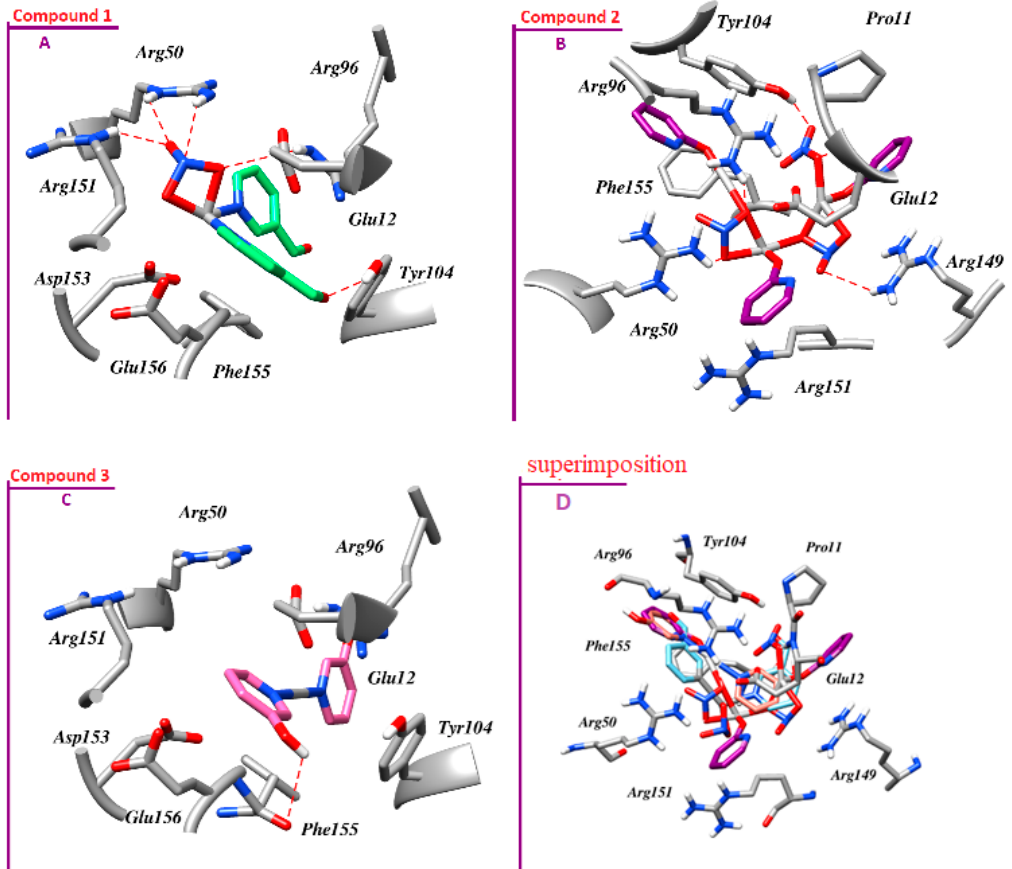
Figure 12. Binding patterns of ( A ) Complex 1 , ( B ) Complex 2 , and ( C ) Complex 3 with thymidylate kinase (TMK) of P. aeruginosa demonstrated from the top ranked dock pose. Red dashed lines represent H-bonds, while ( D ) presents the superimposition of all the compounds.